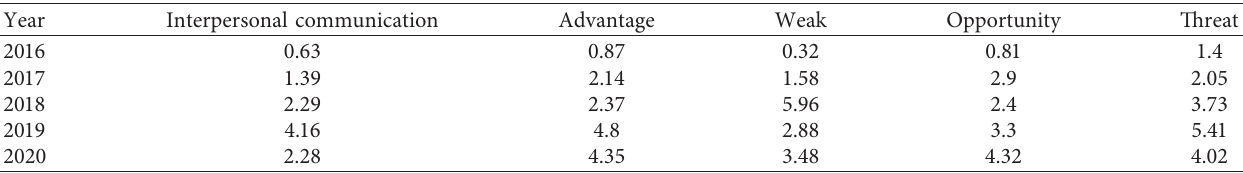
Table 12: High-speed railway in recent years has prompted